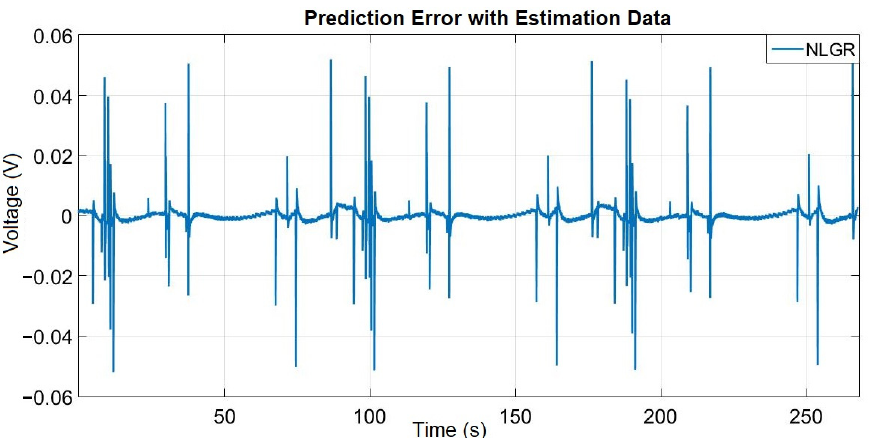
Figure 13. Prediction error validation with the best experiment design.